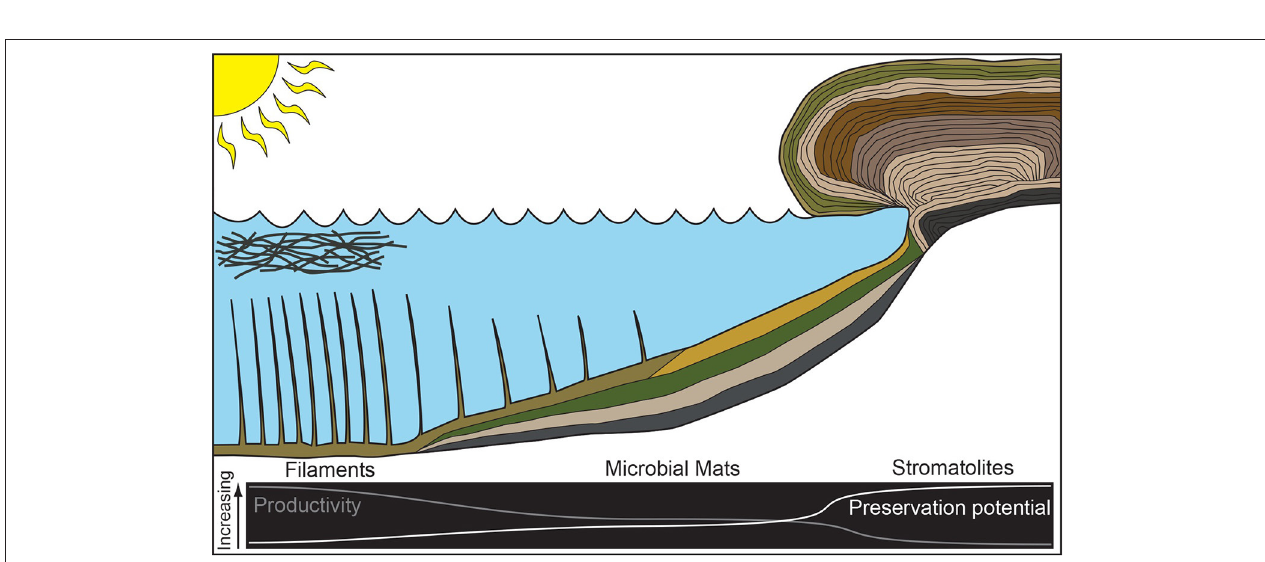
FIGURE 5 | Cartoon illustrating the relationship between productivity and preservation potential for microbial community morphologies sampled in this study.